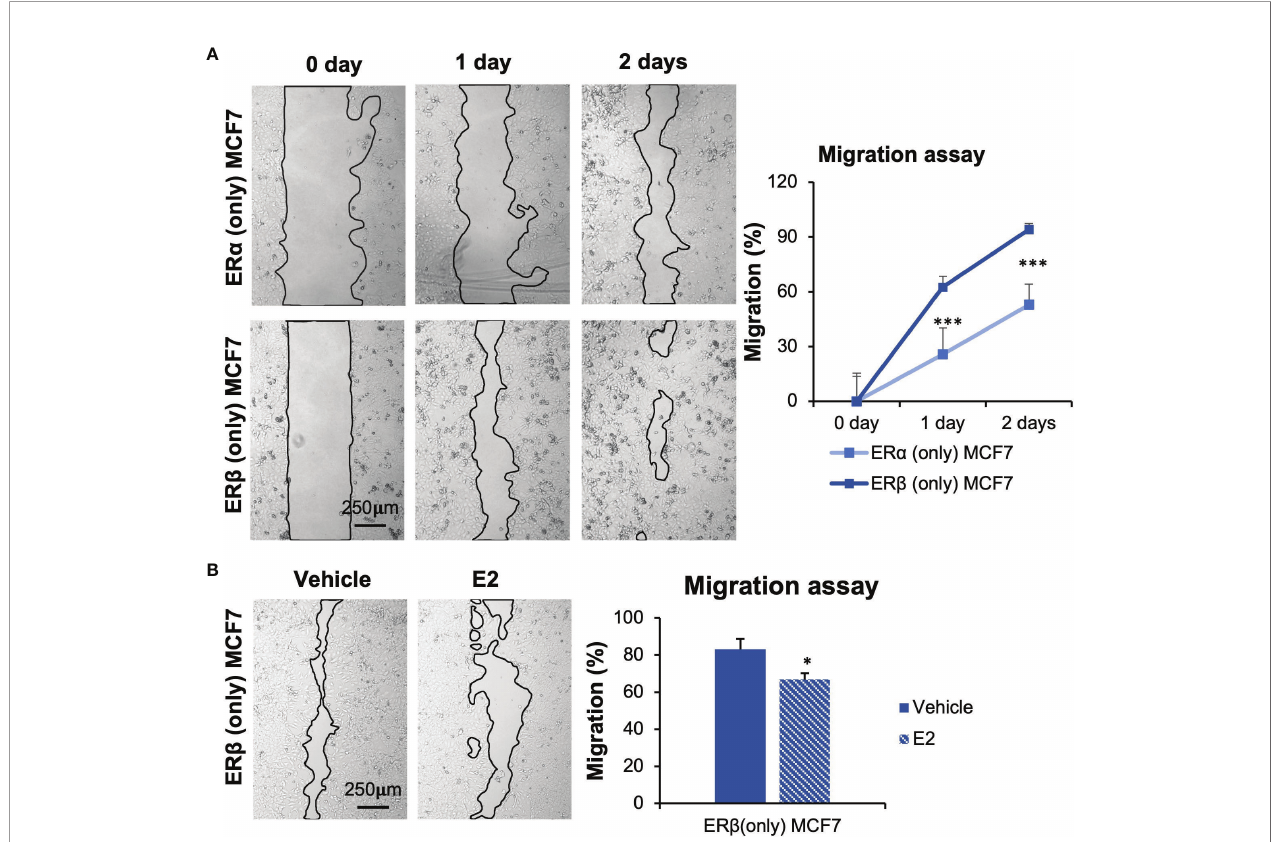
FIGURE 3 | ER a and ER b impact cell migration differently. (A) Wound healing assay was performed using inserts (µ-Dish). Cells were cultured in full-serum medium, and pictures were taken at day 0, 1, and 2 after inserts were removed. Area after migration was measured with ImageJ. The initial area at day 0 for each cell line was used for normalization. (B) Impact of E2 treatment in ER b -expressing MCF7 cells was measured. Cells were seeded in presence of inserts, starved for 72 h, inserts were removed, and cells were treated with E2 or vehicle. Pictures were taken after 2 days. Data is presented as means ± SD (n=6-8). A was analyzed by two-way ANOVA followed by Bonferroni test, B was analyzed by Student ’ s t-test. * P < 0.05, *** P <